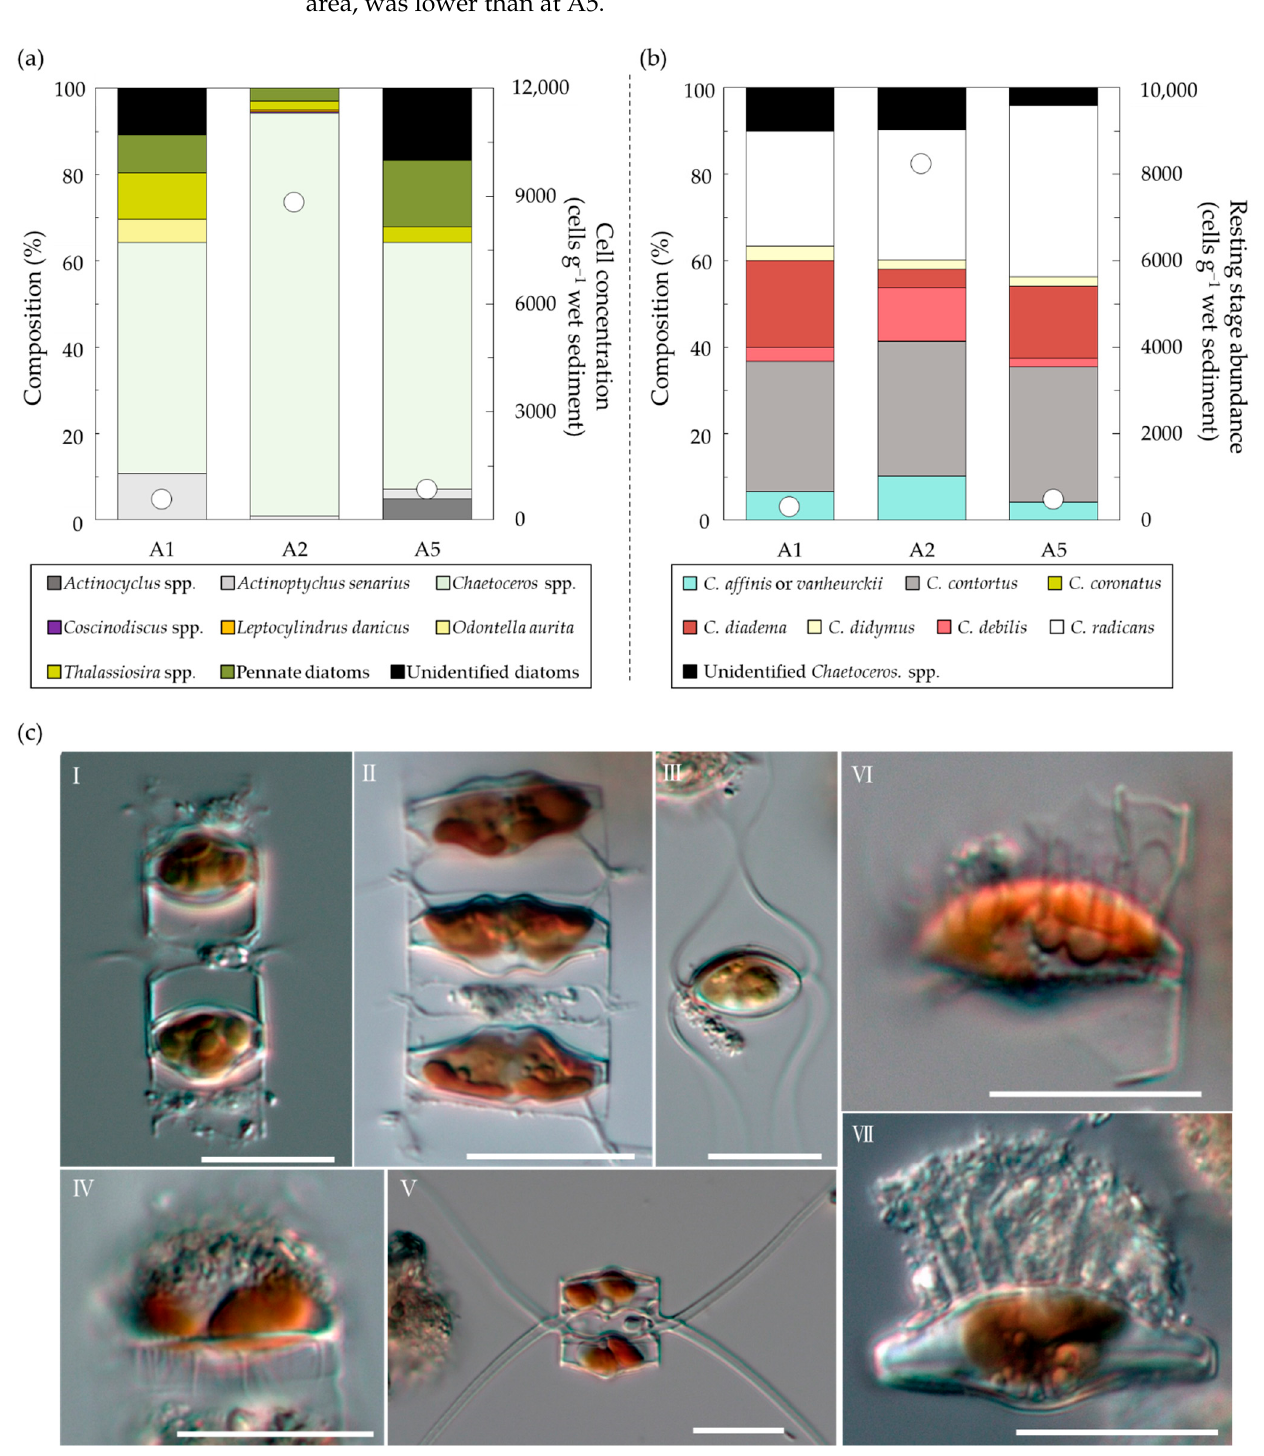
Figure 4. Cell concentrations and species compositions of ( a ) diatoms and ( b ) Chaetoceros species in the bottom sediment at A1, A2, and A5, determined by direct microscopic observation (an open circle represents cell concentration), and ( c ) photomicrographs of the resting spores/cells of Chaetoceros spp.; ( Ⅰ ) C. contortus , ( Ⅱ ) C. debilis , ( Ⅲ ) C. radicans, ( Ⅳ ) C. affinis or vanheurckii , ( Ⅴ ) C. didymus, ( Ⅵ ) C. coronatus, ( Ⅶ ) C. diadema. Scale bars are 20 µm.